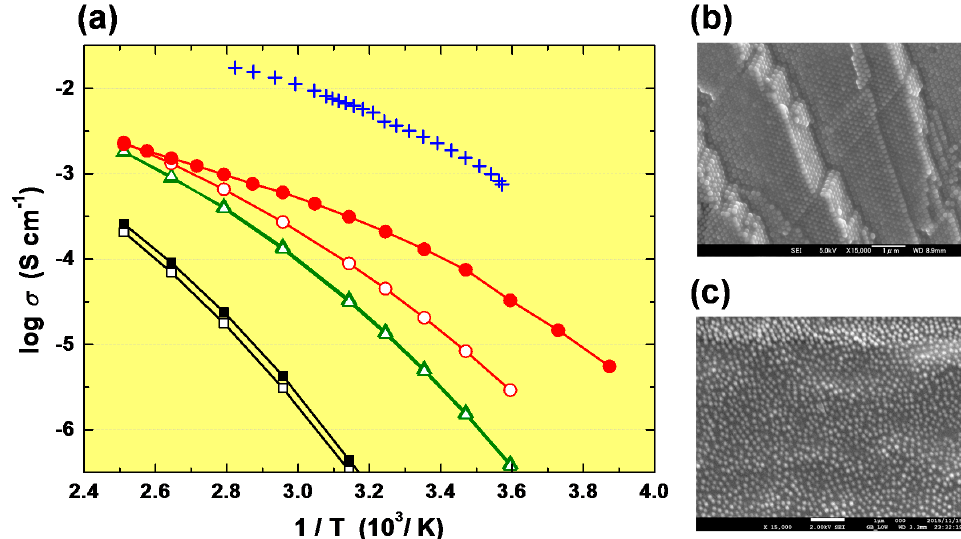
Figure 7. Arrhenius plots of ionic conductivity σ ( a ) for PSiP/IL solid, IL(DEME-TFSI) liquid and bulk poly(DEMM-TFSI) ( M n(theo) = 25,600, 157,000), together with SEM images ( b , c ) of fractured surfaces of PSiP/IL-solid electrolyte observed at a magnification of 15,000×. In the ( a ), red open circle, PSiP/IL solid with polymer brush of M n(theo) = 157,000; red filled circle, PSiP/IL solid with polymer brush of M n(theo) = 25,600; blue cross, DEME-TFSI (ionic liquid); black filled square, bulk poly(DEMM-TFSI) of M n(theo) = 25,600; black open square, bulk poly(DEMM-TFSI) of M n(theo) = 157,000; green filled triangle, bulk poly(DEMM-TFSI) of M n(theo) = 25,600 including 25% of ionic liquid, DEME-TFSI; green open triangle, bulk poly(DEMM-TFSI) of M n(theo) = 157,000 including 25% of ionic liquid, DEME-TFSI. SEM image of PSiP/IL solid with polymer brush of M n(theo) = 25,600 for ( b ) [19] and PSiP/IL solid with polymer brush of M n(theo) = 157,000 for ( c ).